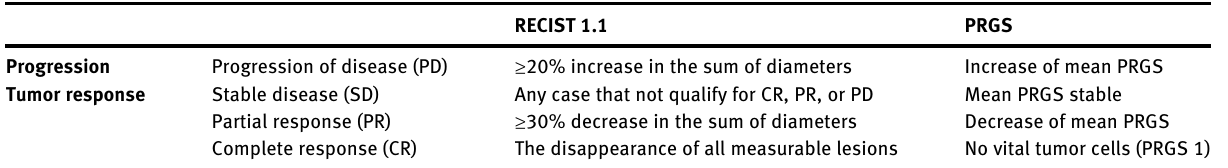
Table  : De fi nition of histological tumor response/progression with the peritoneal regression grading score (PRGS). RECIST  .